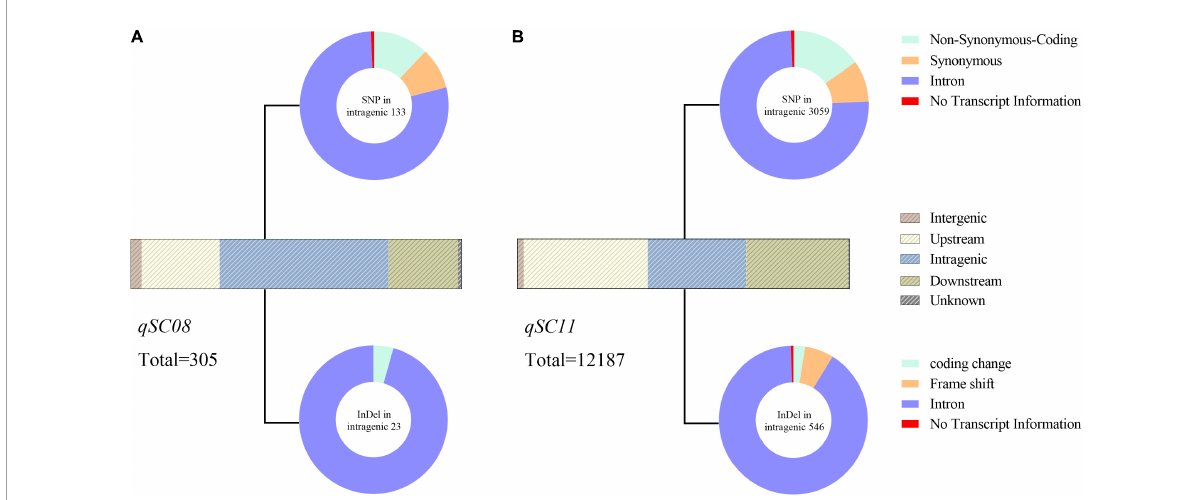
FIGURE4 Analysis of SNPs and InDels between two parents in qSC08 (A) and qSC11 (B) . Strip-shape charts show the distribution of SNPs and InDels in different genomic regions. The upstream and downstream represent the 5 kb within the region of transcription start and stop sites, respectively. Pie charts show the effects of SNP (upside) and InDel (underside) in the intragenic regions. And the corresponding quantity of SNP or InDel is labeled near the pie chart.